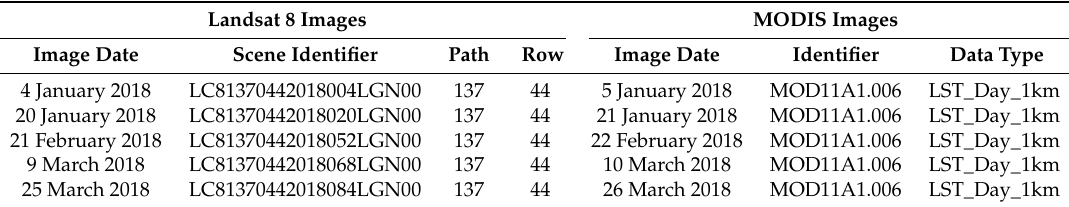
Table 1. Landsat 8 and Terra MODerate Resolution Imaging Spectroradiometer (MODIS) image data used in this